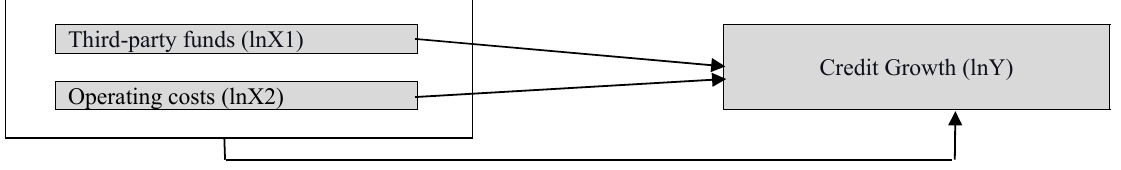
Fig. 1. The proposed